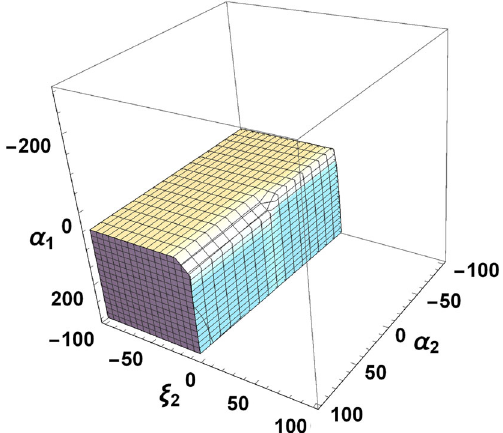
Fig. 7 The non-exclusive saddle regions where the P 8 critical point represents a saddle cosmological epoch ( w m = 0 , z 1 = 0 ,ξ 1 = [ 6 ] > 0 , E [ 2 ] < 0) 2 , E P P 8 8